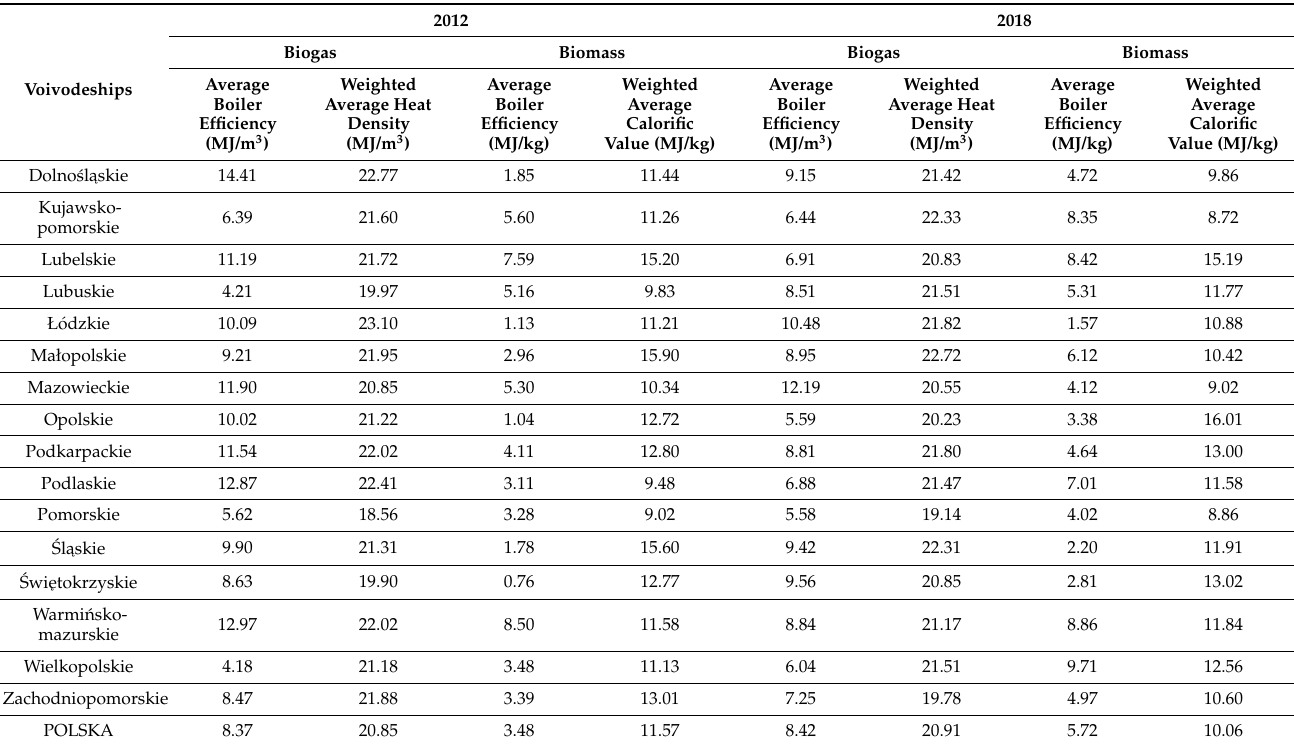
Table 3. Biogas and biomass efficiency by voivodeship in